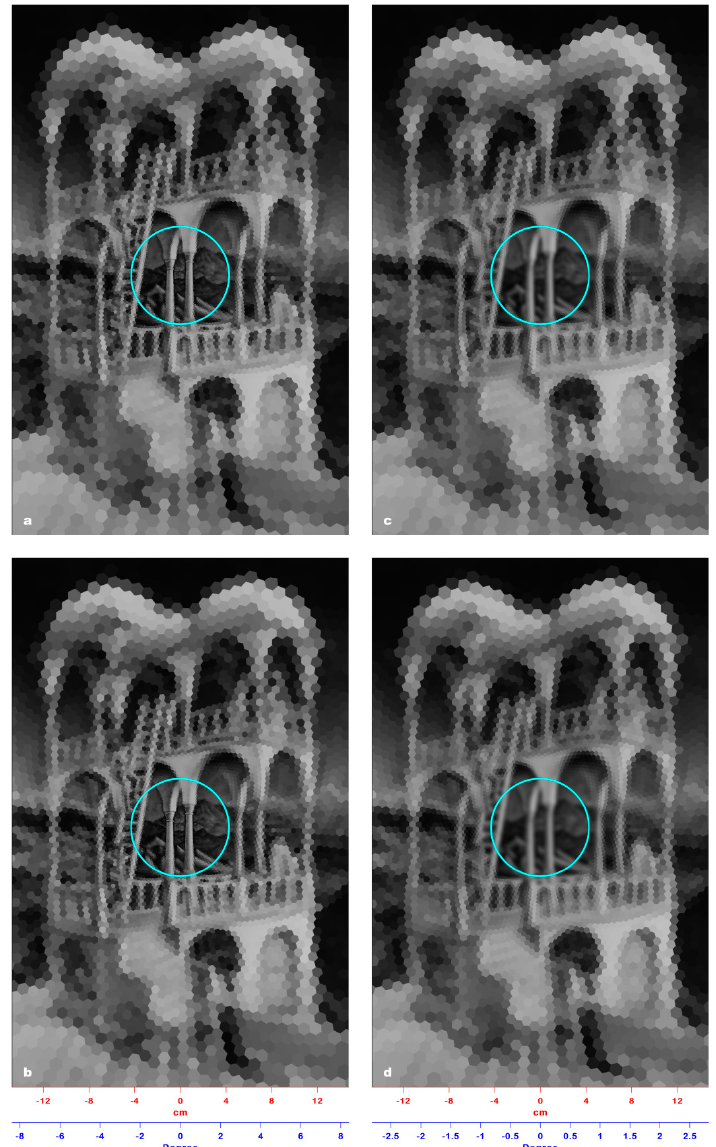
Figure 6. ( a ) The PRI of the entire Belvedere lithograph viewed at a 0.5 m distance. ( b ) The PRI of the entire Belvedere lithograph viewed at a 1 m distance. ( c ) The PRI of the entire Belvedere lithograph viewed at a 2 m distance. ( d ) The PRI of the entire Belvedere lithograph viewed at a 3 m distance. In the four images, the cyan line sets the limit of the pre-attentive perception window, outside of which the spatial resolution is comparably too low to allow any incoherence perception, making the four PRIs indistinguishable from each other.